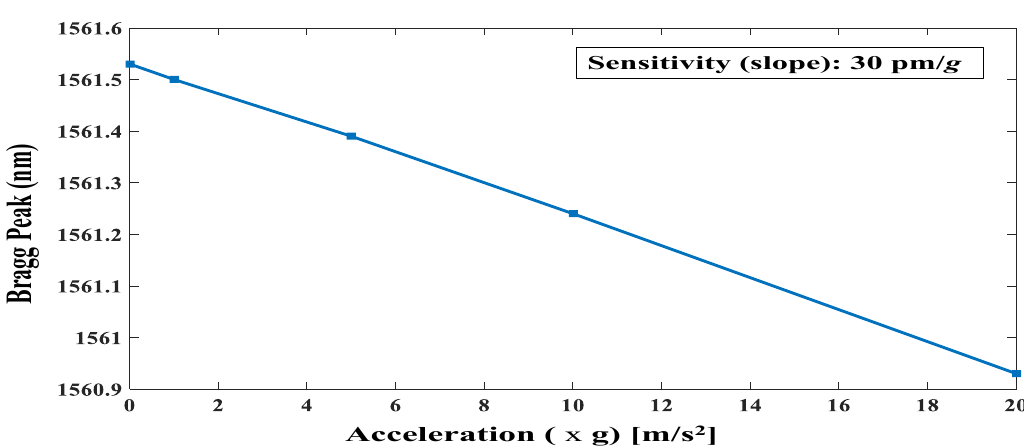
Figure 10. Reflection spectra for Grating-3 for different parallel accelerations.